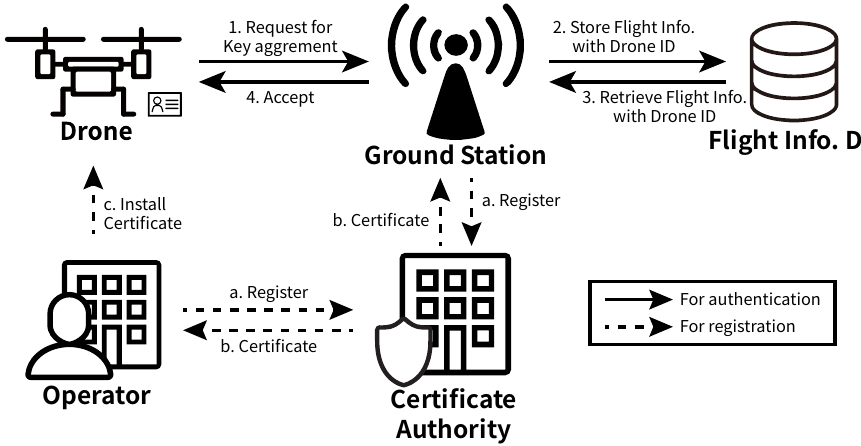
Figure 2. Overall process of